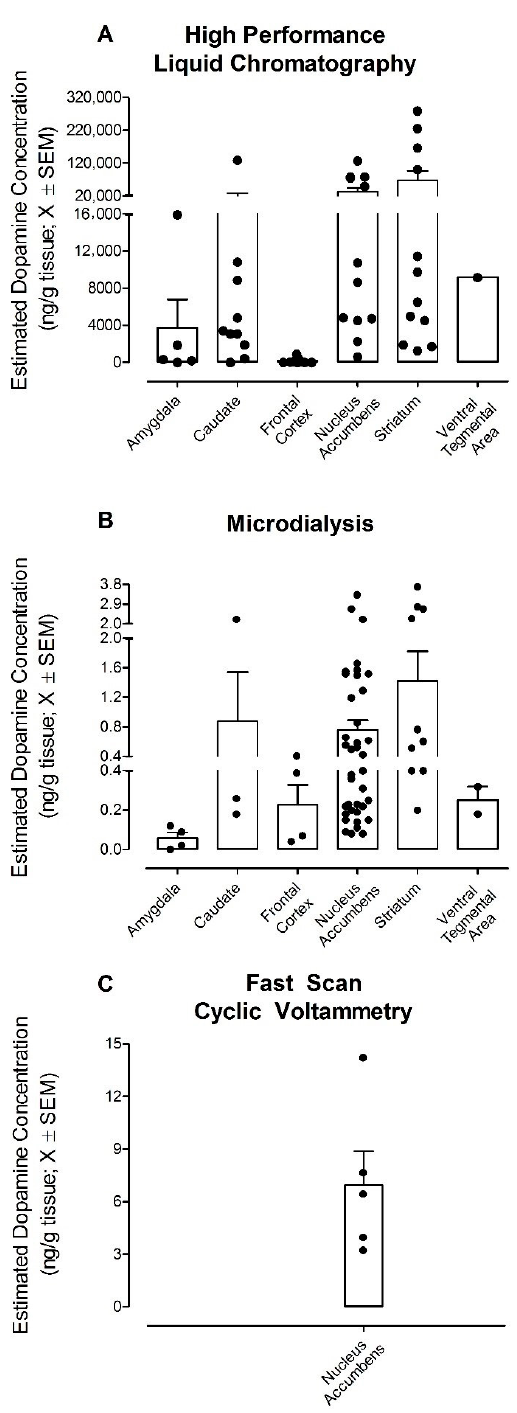
Figure 1. Graphical illustration of the profound differences in estimated dopamine (DA) concen- tration (ng/g of tissue; X ± SEM) dependent upon methodology (i.e., ( A ) high-performance liquid chromatography, ( B ) microdialysis, ( C ) fast-scan cyclic voltammetry) and brain region. Each dot represents the estimated DA concentration from a